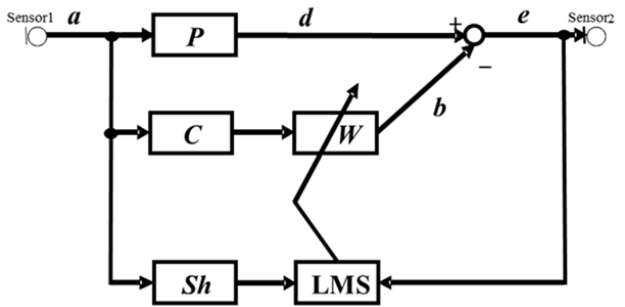
Figure 8. Block diagram of adaptive filter.